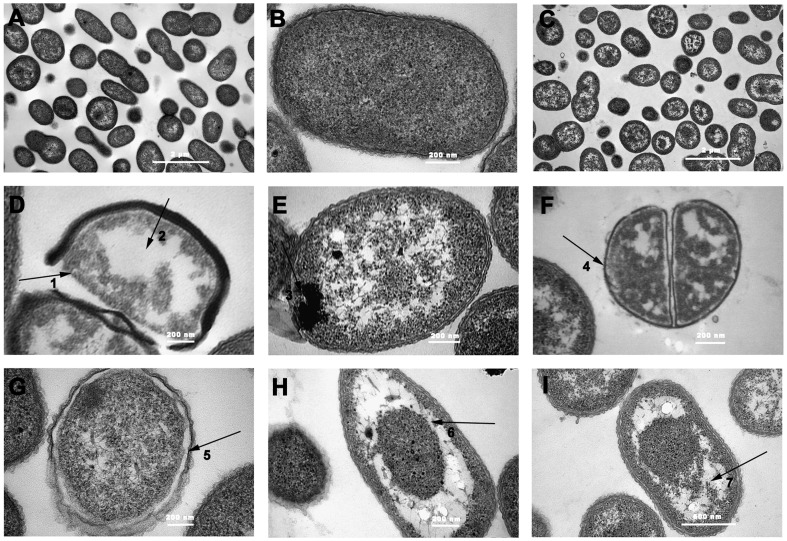
Transmission electron micrographs (TEM) of C. michiganense subsp. sepedonicum cells.Untreated (A, 20000×; B, 120000×); treated with Fractionation three at the MIC concentration (C, 20000×; D, F, G, H, 100000×; E, 120000×; I, 80000×). Disintegration of cell wall (1, 3), cytoplasm separated from cell wall and cell membrane (4, 5), large vacuoles inside the cells (2, 6, 7). MIC, Minimum inhibitory concentration.